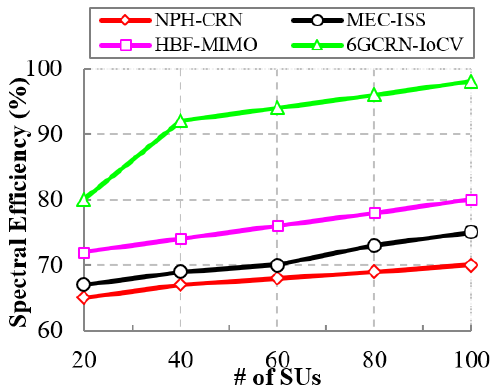
Figure 16. Spectral efficiency vs. the number of